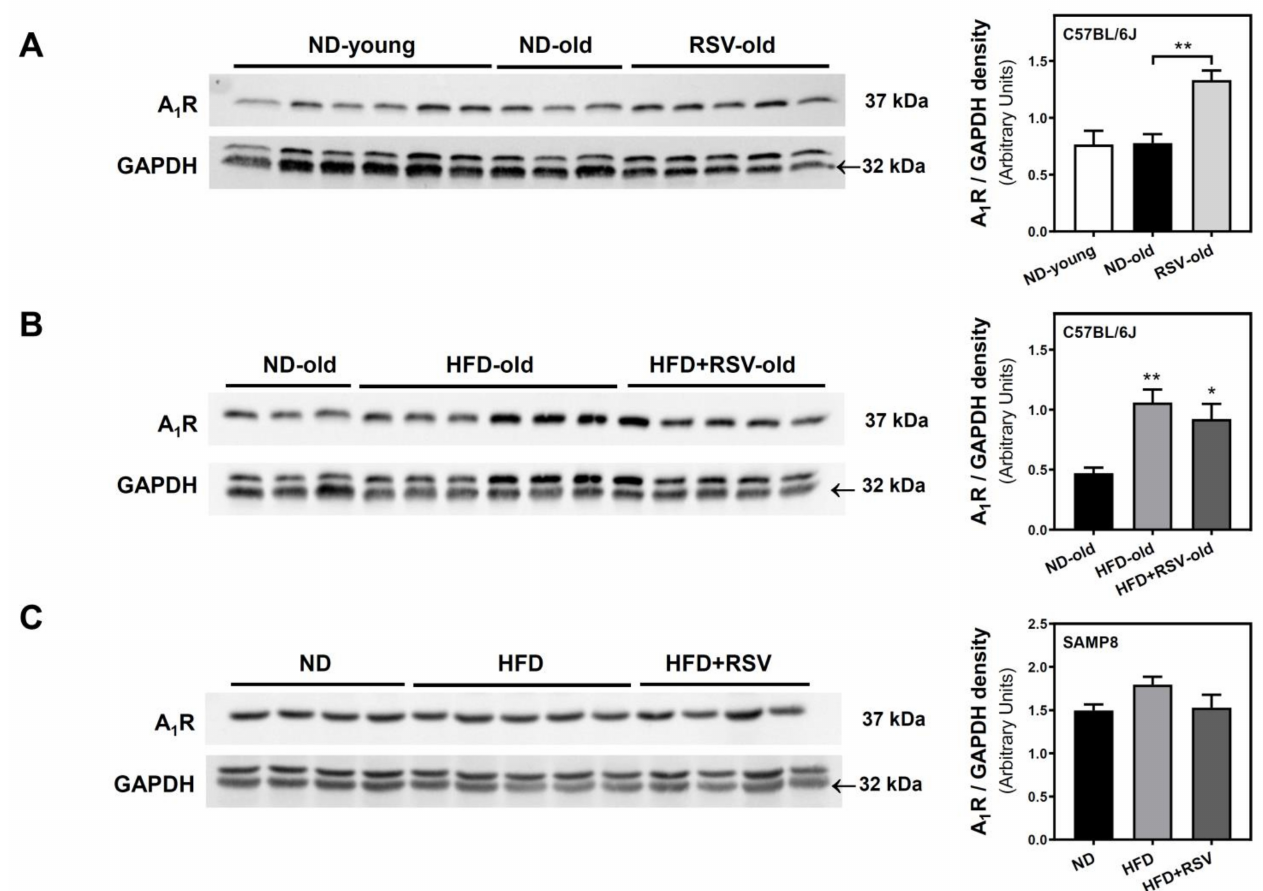
Figure 2. Adenosine A 1 receptor levels in the cerebral cortex. A 1 Rs were quantified by Western blotting assay in plasma membrane fraction carried out as described in Methods. Figures represent the level of this receptor in the cerebral cortex of C57BL/6J ( A , B ) and SAMP8 ( C ) mice. Results are mean ± SEM of three-six different samples. GAPDH was used as a loading control. The upper GAPDH band correspond to the A 1 R band. * p < 0.05 and ** p < 0.01 significantly different from ND-old group according to one-way